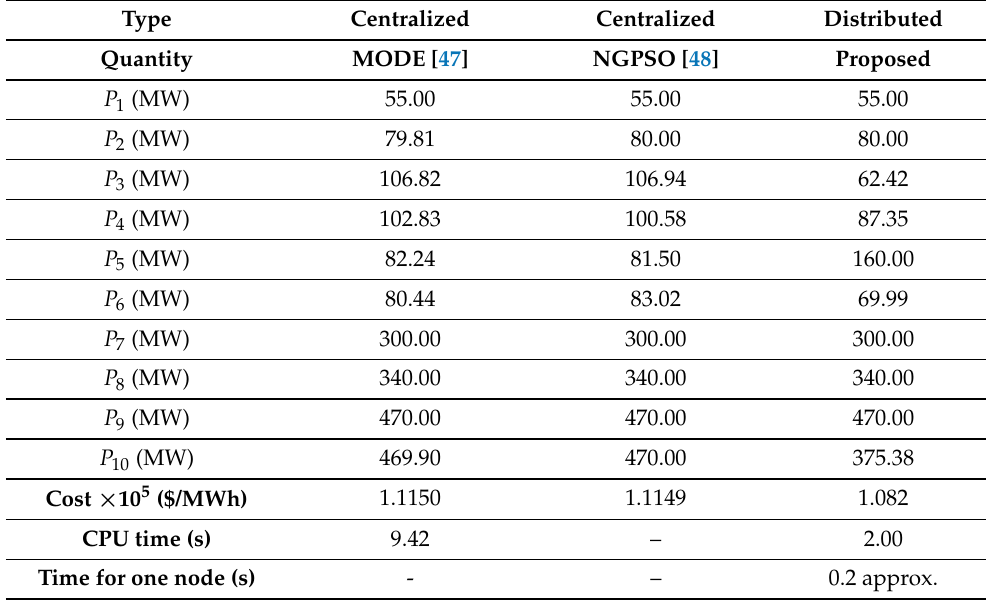
Table 4. Generation, cost, and CPU time comparison for ten-unit system ( P D = 2000